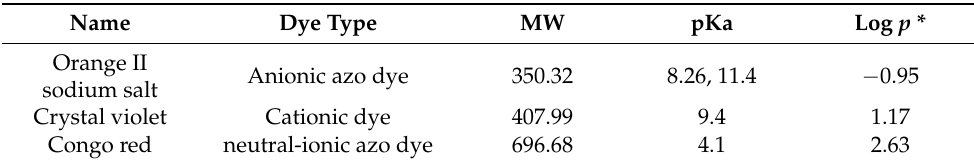
Table 3. Information of selected organic dyes.